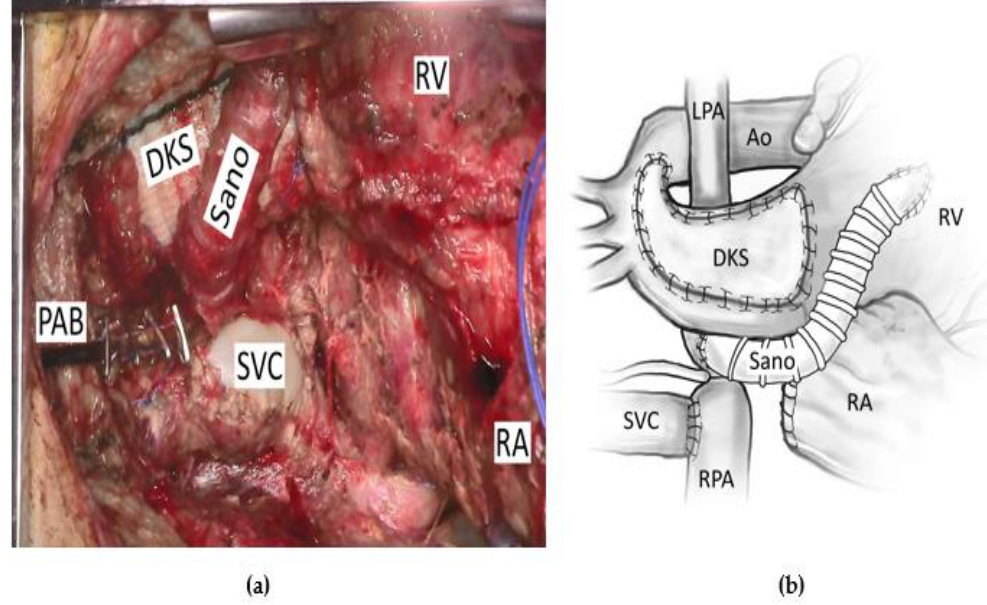
Figure 1. A patient undergoing a left ventricular recruitment procedure with ( a ) an operative picture and ( b ) a pictorial description of the same operation. Ao = aorta, DKS = Damus–Kaye–Stansel anastomosis, LPA = left pulmonary artery, PAB = pulmonary artery band, RA = right atrium, RPA = right pulmonary artery, RV = right ventricle, SVC = superior vena cava.